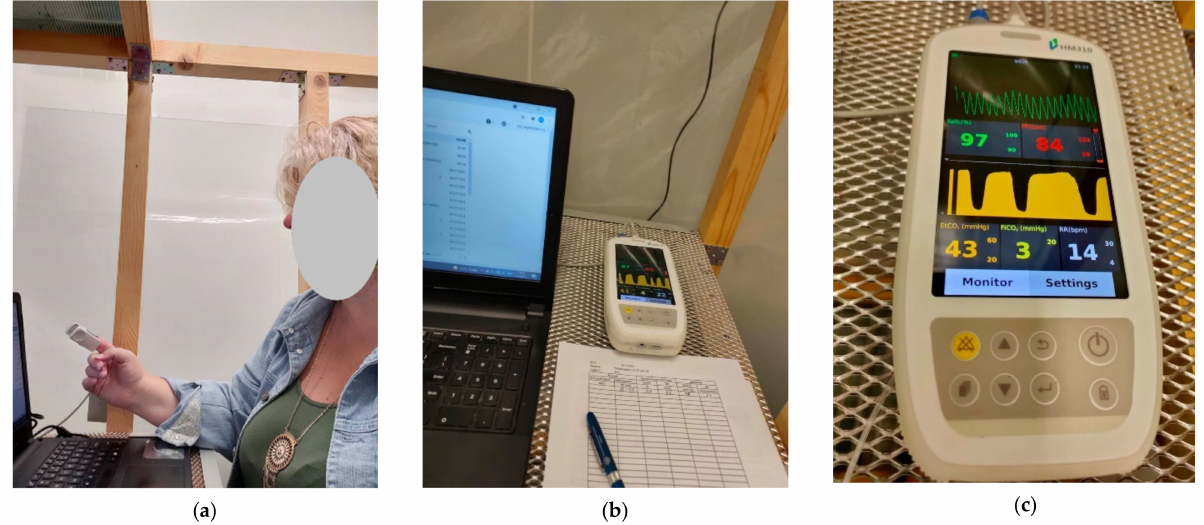
Figure 11. During the exposure in the climate chamber: ( a ) A self-portrait of the participant during the exposure; ( b ) Inside the exposure chamber; ( c ) The Capnograph Monitor-W HM